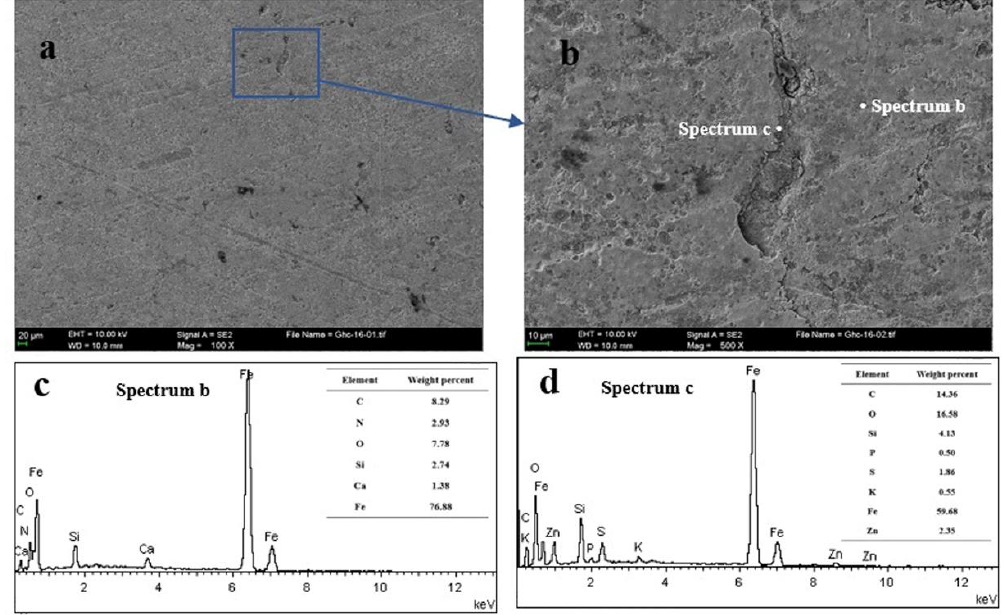
Figure 8. Surface topography ( a ), enlarged area topography ( b ) and position b ( c ) and position c ( d ) element contents of the cylinder liner matched with Cr coated piston ring.